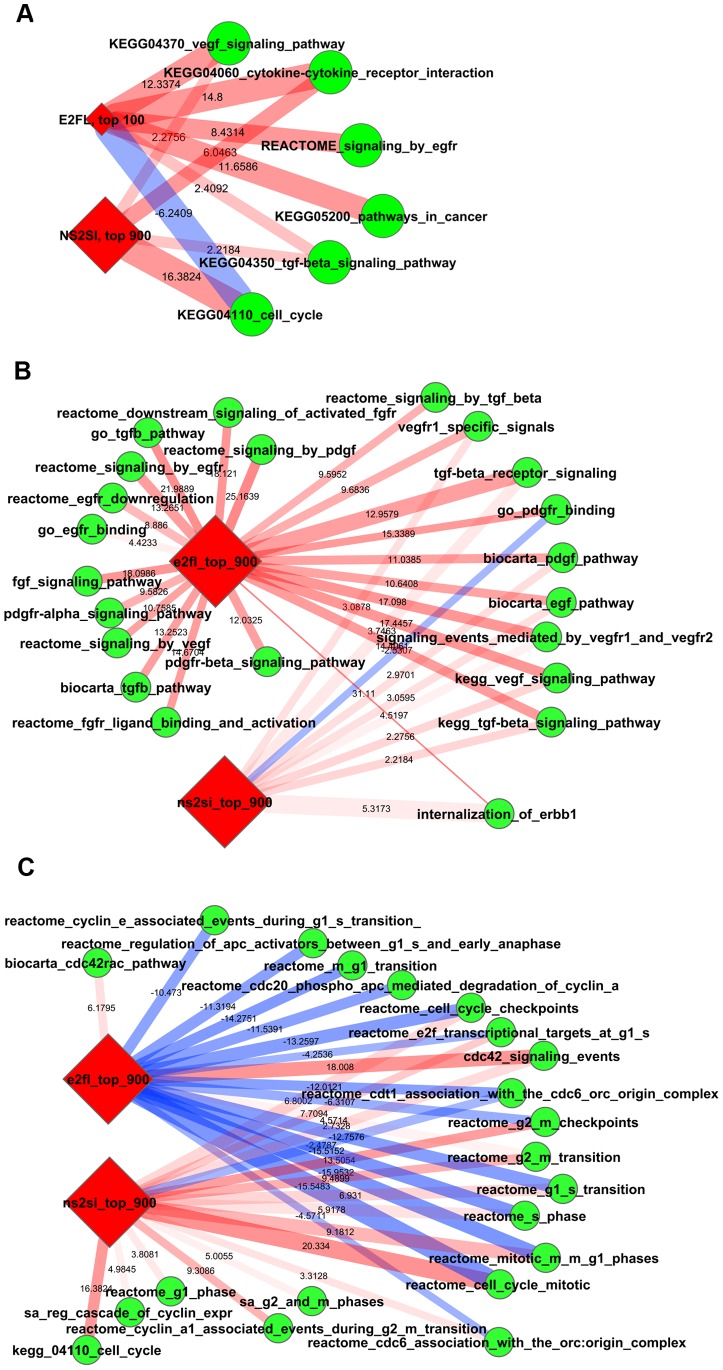
Pathways influenced by both syndecan-1 overexpression and silencing, revealed by network enrichment (NEA) analysis.Altered KEGG pathways (A); pathways determining signaling and growth factor activity (B); pathways related to particular phases of the cell cycle (C). Diamonds represent differentially expressed genes (E2FL denotes cells transfected with full-length syndecan-1 vs. cells transfected with empty vector; NS2SI denotes cells silenced for syndecan-1vs scrambled control); circles represent pathways from different databases (FGS). Red lines denote enriched pathways, blue lines denote depleted pathways. Line width is proportional with the number of individual gene-gene network links between two gene sets (linear scales from min 7 to max 3,995). Line opacity represents confidence (FDR<0.1 for every shown link). Numbers at lines correspond to Z-scores from network enrichment analysis of differentially expressed genes as groups versus genes of FGS as groups. The picture was generated using the stand-alone network software Cytoscape [109] using network edges and nodes from the custom NEA software.